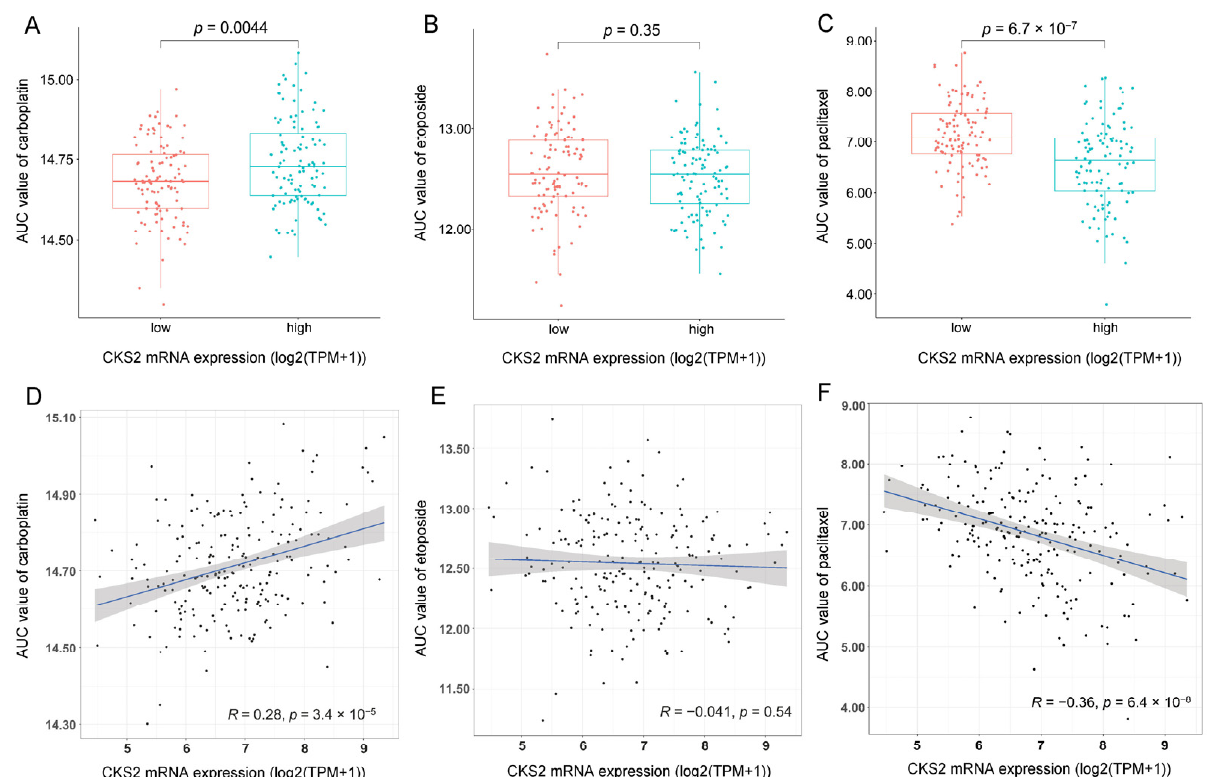
Figure 3. Association between the CKS2 and drug sensitivity. ( A – C ) Sensitivity of the CKS2-low and CKS2-high expression groups to different chemotherapeutic drugs. ( D – F ) Correlation between CKS2 expression and the AUC value of chemotherapeutic drugs.